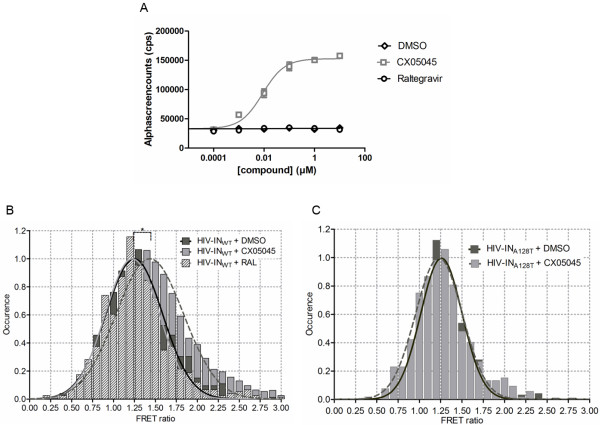
LEDGINs enhance multimerization of HIV integrase. (A) Direct and specific interaction of LEDGINs with HIV-1 Pol polyprotein. (A) Titration of CX05045 or raltegravir against a constant background of 33 nM His-MBP-sPol-PRD25N and 33 nM GST-sPol-PRD25N. DMSO (vehicle) included as no-inhibitor control. Only CX05045 was able to enhance the Pol-Pol multimerization with an EC50 of 8.7 nM (95% CI 5.7-13.4). Data represent mean values ± standard deviations of duplicate measurements in two independent experiments. (B, C) FRET analysis of IN multimerization in the virions. Histograms were plotted from pooled data of two independent experiments for (B) wild type HIV-1 (HIV-INWT) and (C) LEDGIN-resistant (HIV-INA128T) virions. (B) FRET ratios for populations of fluorescent HIV-INWT virions produced in the presence of DMSO (dark gray bar), CX05045 (light gray bar) or RAL (hatched bar) along with the respective normal distribution fits for DMSO (dark line), RAL (light gray line) and CX05045 (broken line) are shown. The calculated mean and 95% CI of the FRET ratios for HIV-INWT are 1.25 (95% CI 1.23-1.28) (DMSO), 1.22 (95% CI 1.19-1.25) (RAL) and 1.43 (95% CI 1.42-1.45) (CX05045). (C) FRET ratios for populations of fluorescent HIV-INA128T virions produced in the presence of DMSO (dark gray bar) or CX05045 (light gray bar) along with the respective normal distribution fits for DMSO (dark gray line) and for CX05045 (broken line) are shown. The calculated mean and 95% CI of the FRET ratios for HIV-INA128T when produced in the presence or absence of CX05045 are 1.23 (95% CI 1.21-1.25) and 1.26 (95% CI 1.24-1.27), respectively. A mean FRET ratio that equals unity means no FRET. *p <0.05; Student t test.